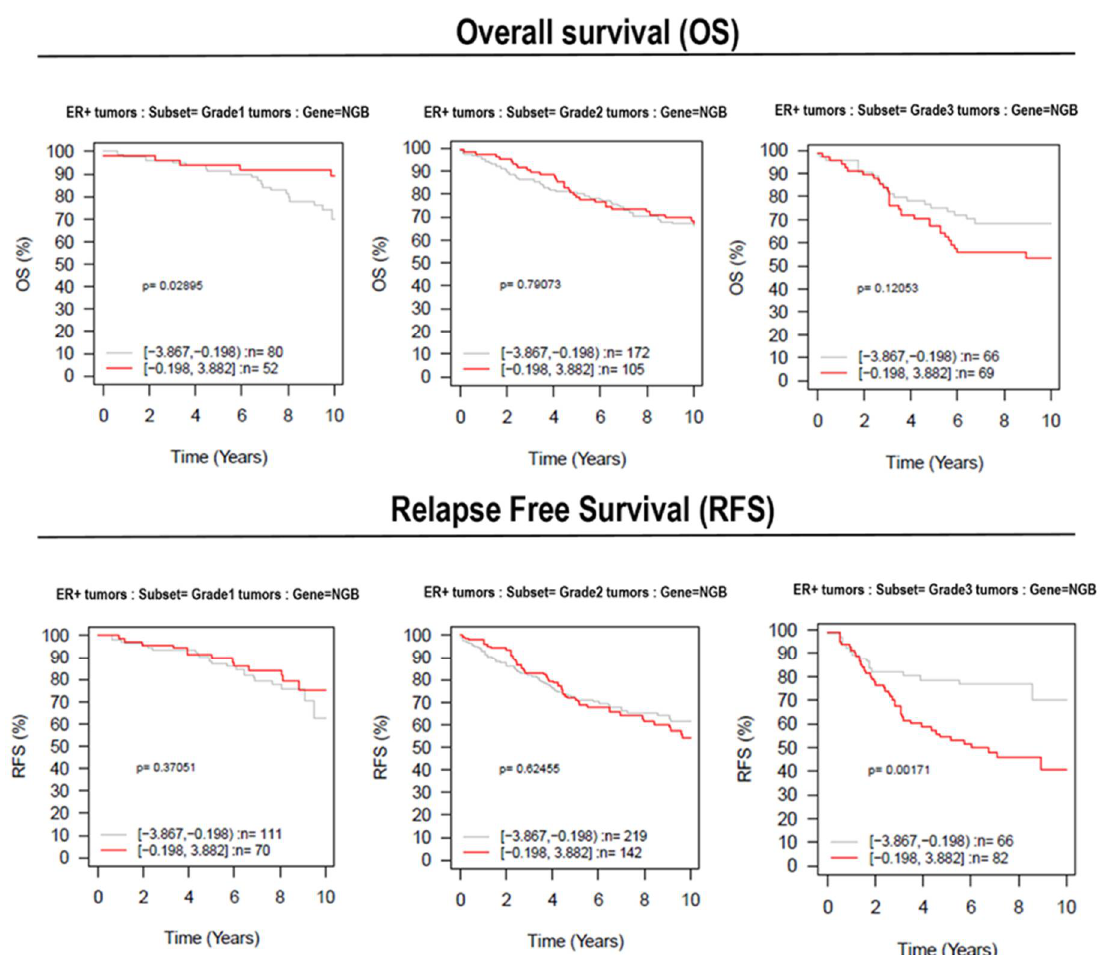
Figure 5. Data set analysis of survival in patients with different NGB expressions. Kaplan–Meier plots of high (red line) or low (gray line) NGB-expressing tumor samples (ID = 58157) available in the GOBO (Gene expression-based Outcome for Breast cancer Online). The data have been selected from ER α + samples based on tumor grade (lowest at left, highest at right). The overall (upper panels) and the relapse-free (bottom panels) survival have been selected as outcomes.